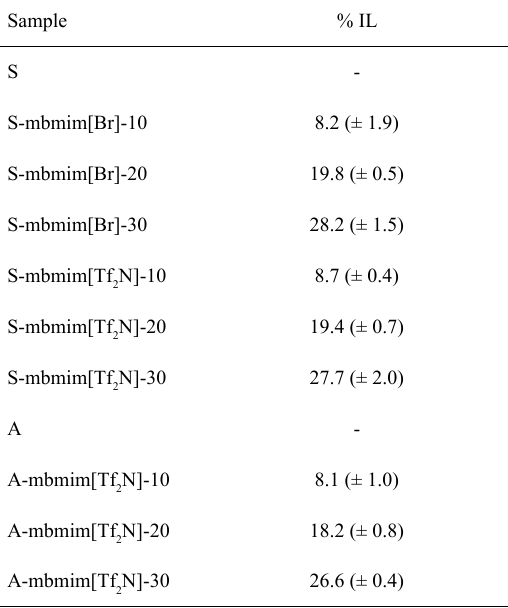
Table 1. Amount (%) of immobilized IL in supports S and A determined by TGA. Sample